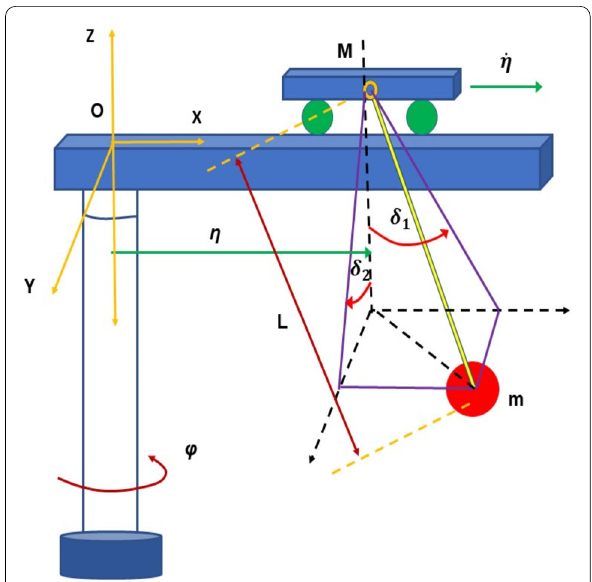
Figure 1 Diagram of the 4-DOF robotic tower crane